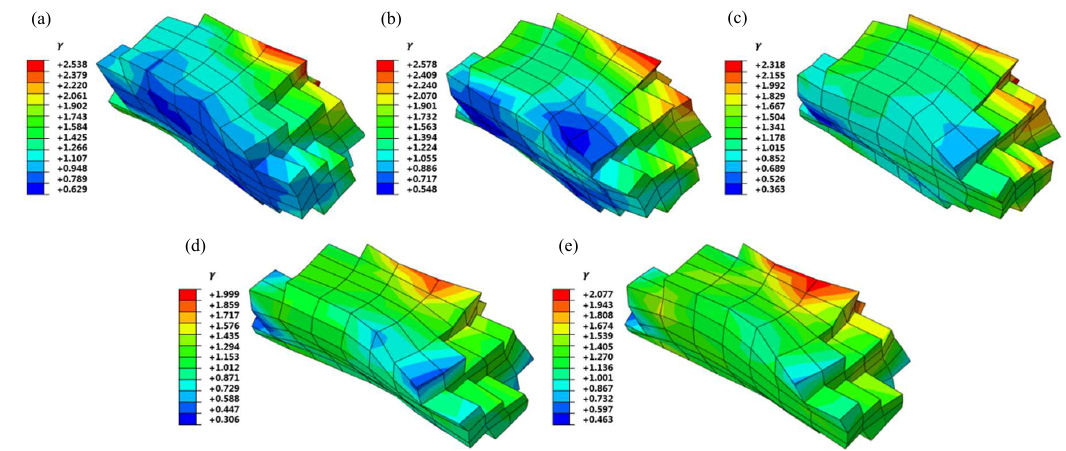
Figure 9. Cumulative shear strain distribution after the G411 deformation: ( a ) Brass; ( b ) Copper; ( c ) S; ( d ) Cube; ( e ) Goss.